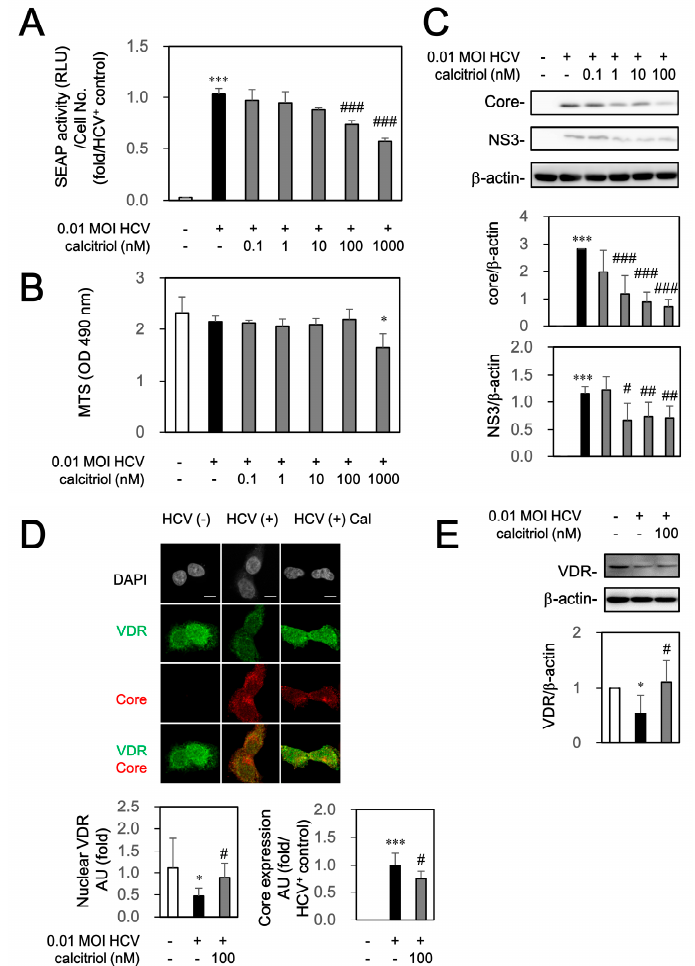
Figure 1. Effects of calcitriol on SEAP activity ( A ); cell viability ( B ) and protein expressions of NS3 ( C ); core ( C , D ) and VDR ( D , E ). ( A ) Huh7.5-SEAP cells (8 × 10 3 ) were infected with HCV (MOI